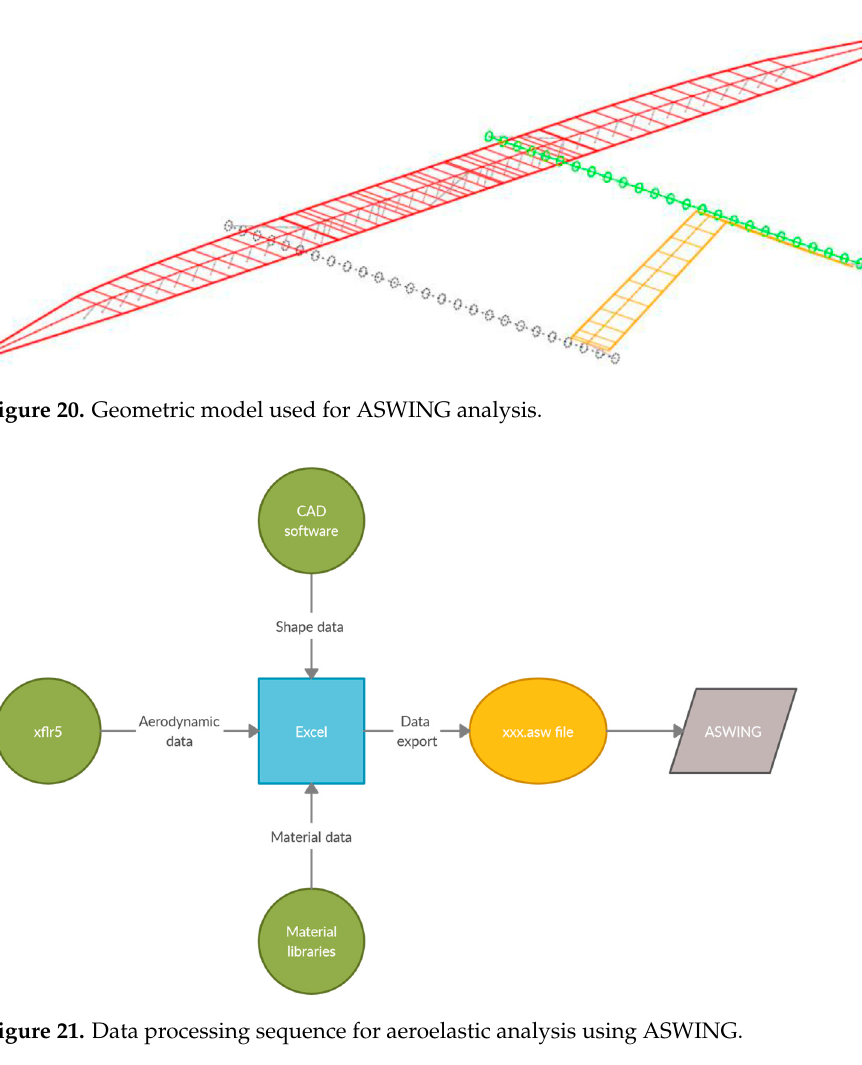
Figure 21. Data processing sequence for aeroelastic analysis using ASWING. The flutter speed and actual flutter frequency are indicated by one of the eigenvalues crossing over from left to right of the imaginary axis. Flight-dynamic instabilities (e.g., spiral mode) will also have eigenvalues on the right side of the imaginary axis, but these will typically be at a near-zero frequency and will have completely different eigenmodes.